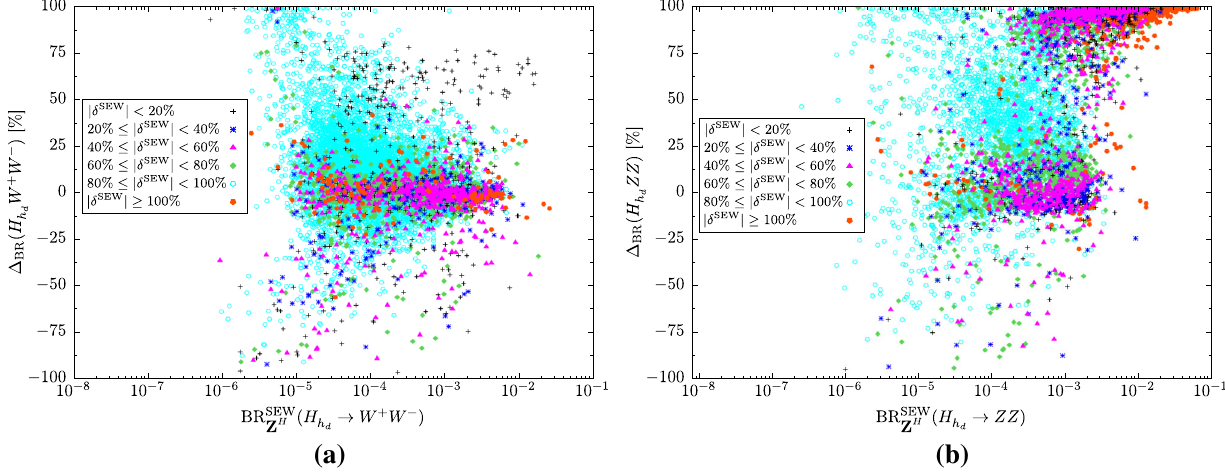
Fig. 7 Scan2: Relative difference (cid:20) BR in percent for the h d -like Higgs boson H h into a W boson pair (left) and into a Z boson pair (right) as d a function of the corresponding loop-corrected branching ratio. Black: relative corrections δ SEW in percent of the SUSY-EW corrections to